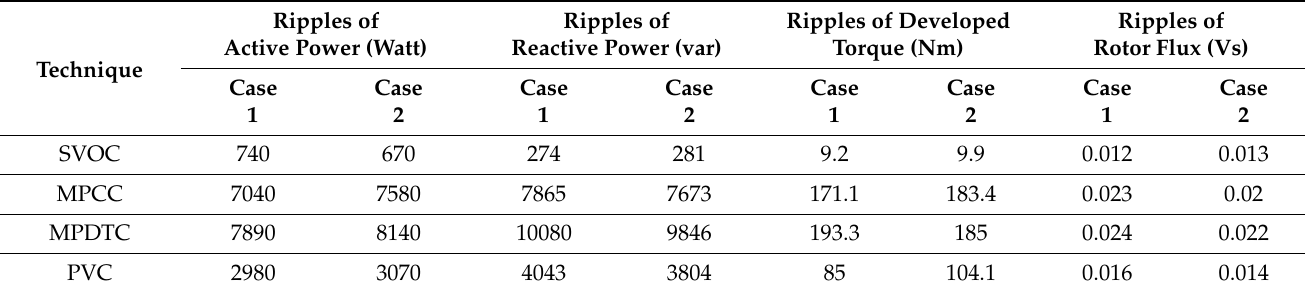
Table 2. Ripples content of the actual values above their references values.